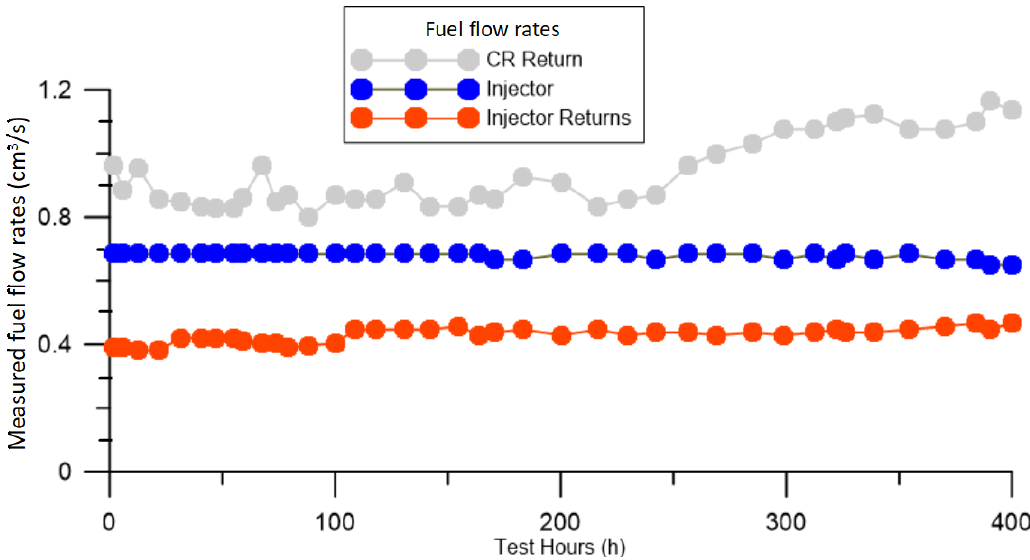
Figure 8. Evolution of the measured fuel flow rates during the experiment (injected and returns flow rates).